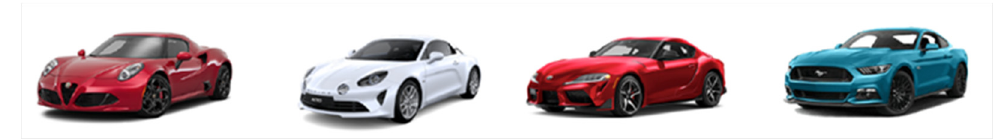
Figure 6. Benchmark vehicles. from left to right: Alfa Romeo 4C, Lotus Elise, Toyota Supra Mk.5 and Ford Mustang GT Fastback.